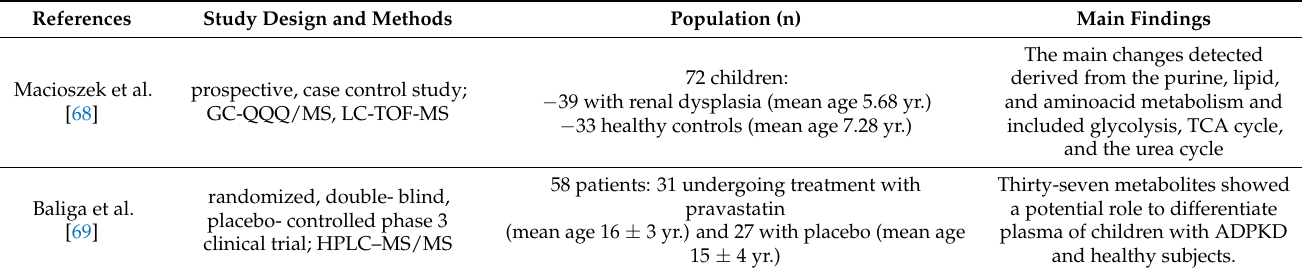
Table 2. Main findings of omics studies in renal cystic disease in